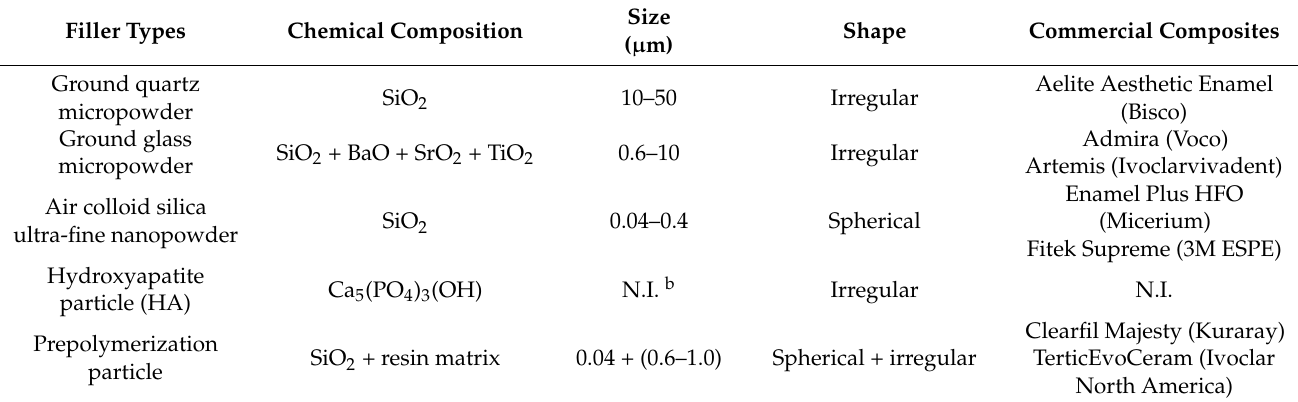
Table 1. Particulate fillers for dental resin composites a .